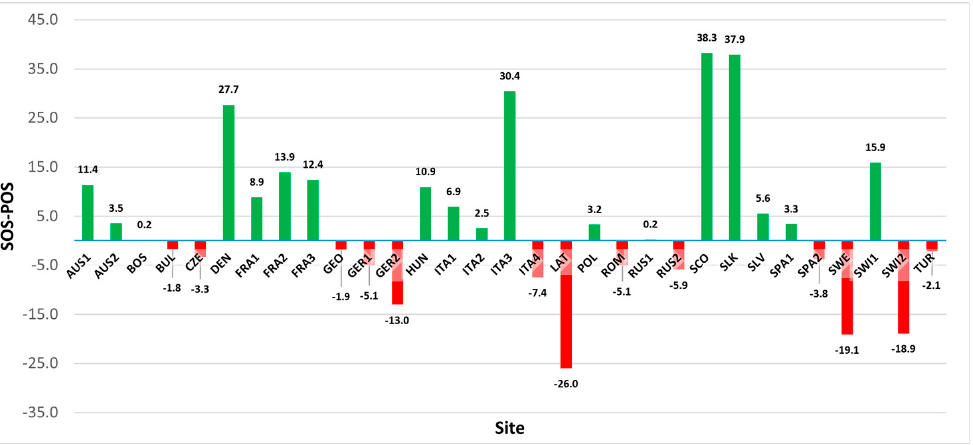
Figure 7. Changes in SOS-POS (number of days) interval during the period 2001–2021 for all test sites.